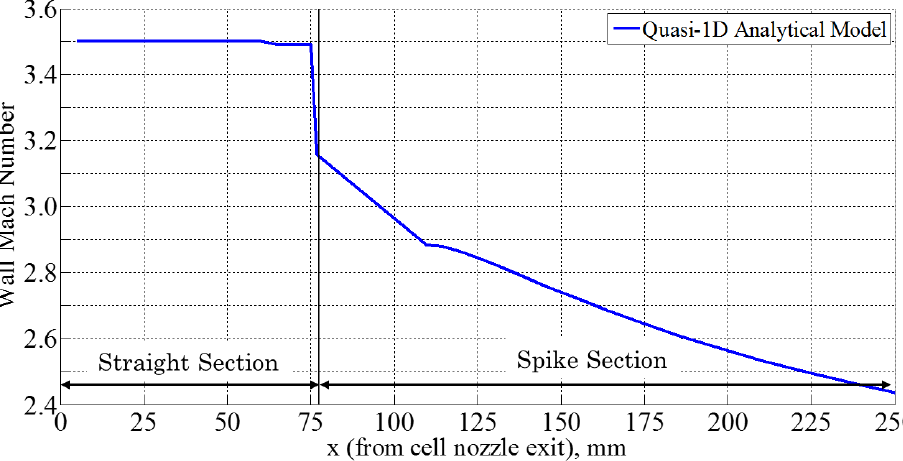
Aerospace 2018 , 5 , x FOR PEER REVIEW Figure 9. Spike wall Mach number distribution predicted by the analytical model.